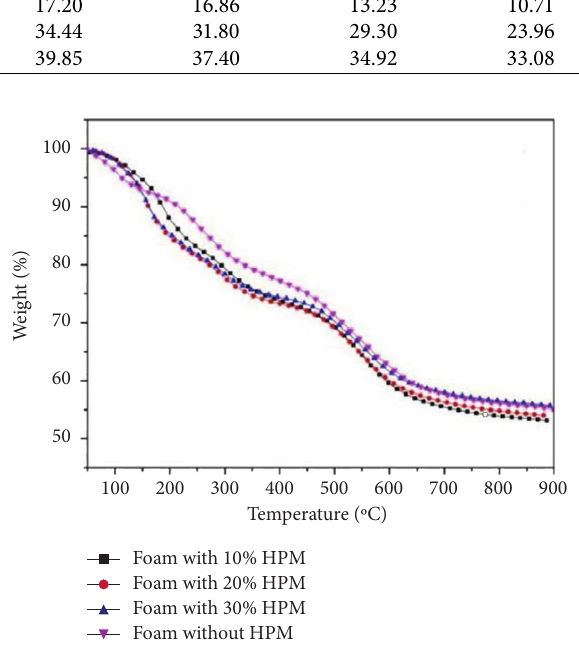
Figure 14: TG curves of HPM/phenolic syntactic